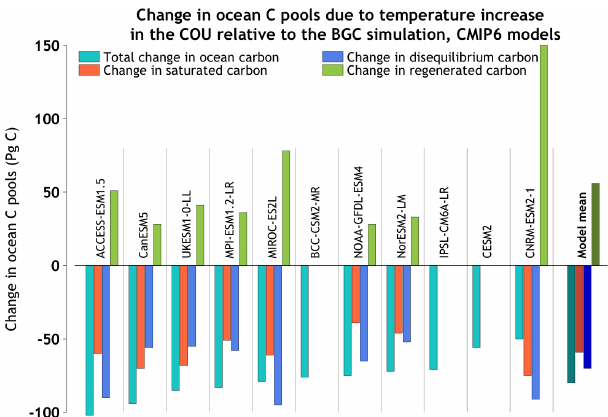
Figure 13. Change in saturated, disequilibrium, and regenerated carbon pools in the fully coupled minus the biogeochemical sim- ulation using Eq. (14), which contributes to the calculation of the carbon–climate feedback over the ocean. The sum of the partitions does not exactly match the total ocean uptake diagnosed from the air–sea fluxes due to land–ocean interactions involving storage in sediments and river